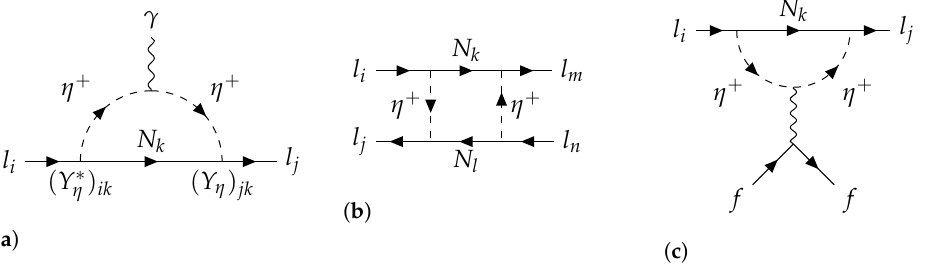
Figure 5. CLFV processes in the scotogenic model. ( a ) Diagrams contributing to the l i → l j γ rate. ( b ) Box diagrams contributing to the l i → l m l n l j rate. ( c ) Penguin diagrams contributing to the l i → l j l k l k rate and µ → e conversion rate ( f can be a quark or a